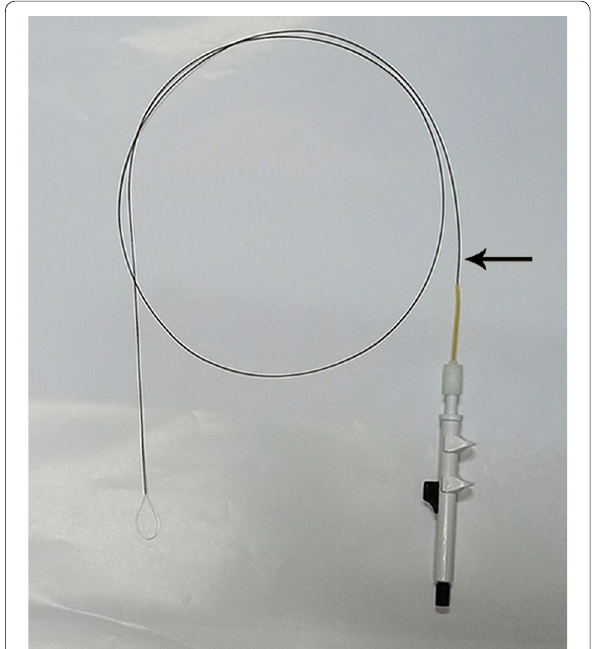
Fig. 3 In case of entrapped basket around the calculus the basket can be cut proximally near the handle (shown by arrow mark) to make stone fragmentation and subsequent basket retrieval easier